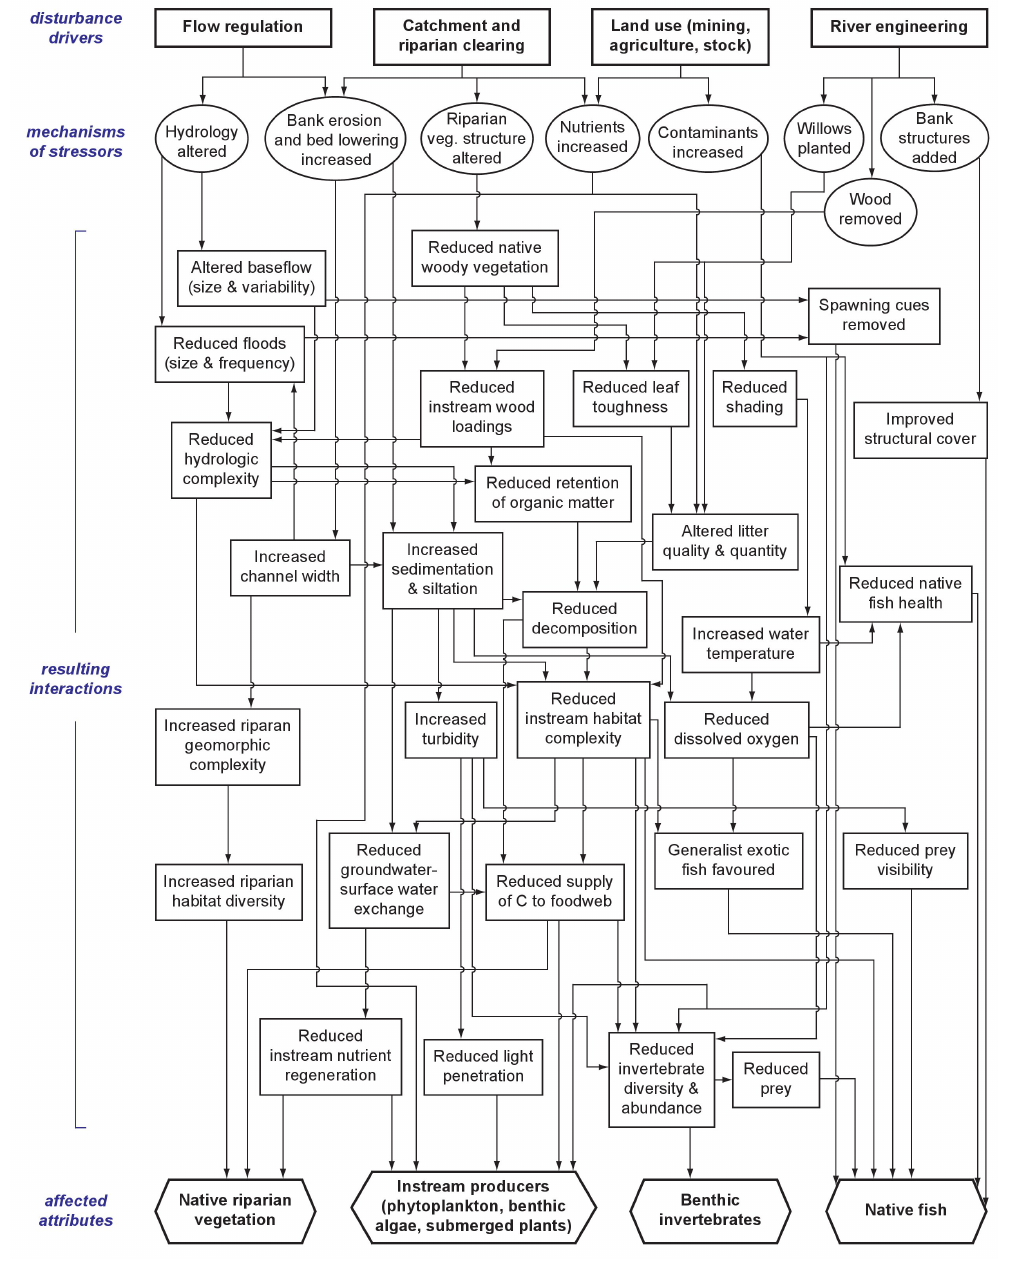
Fig. 5 . The interdisciplinary conceptual model of the contemporary starting point (2003) for restoring instream and riparian structure and function in the UHRRI reach. The model emphasizes (i) the key drivers of disturbance in the system that can be tackled by river managers (heavy rectangles), (ii) the specific mechanisms by which these drivers stress the system (ovals), (iii) the direct and indirect interactions of stressors with each other and with system components (light rectangles), and (iv) the ecological attributes affected by these stressors (heavy